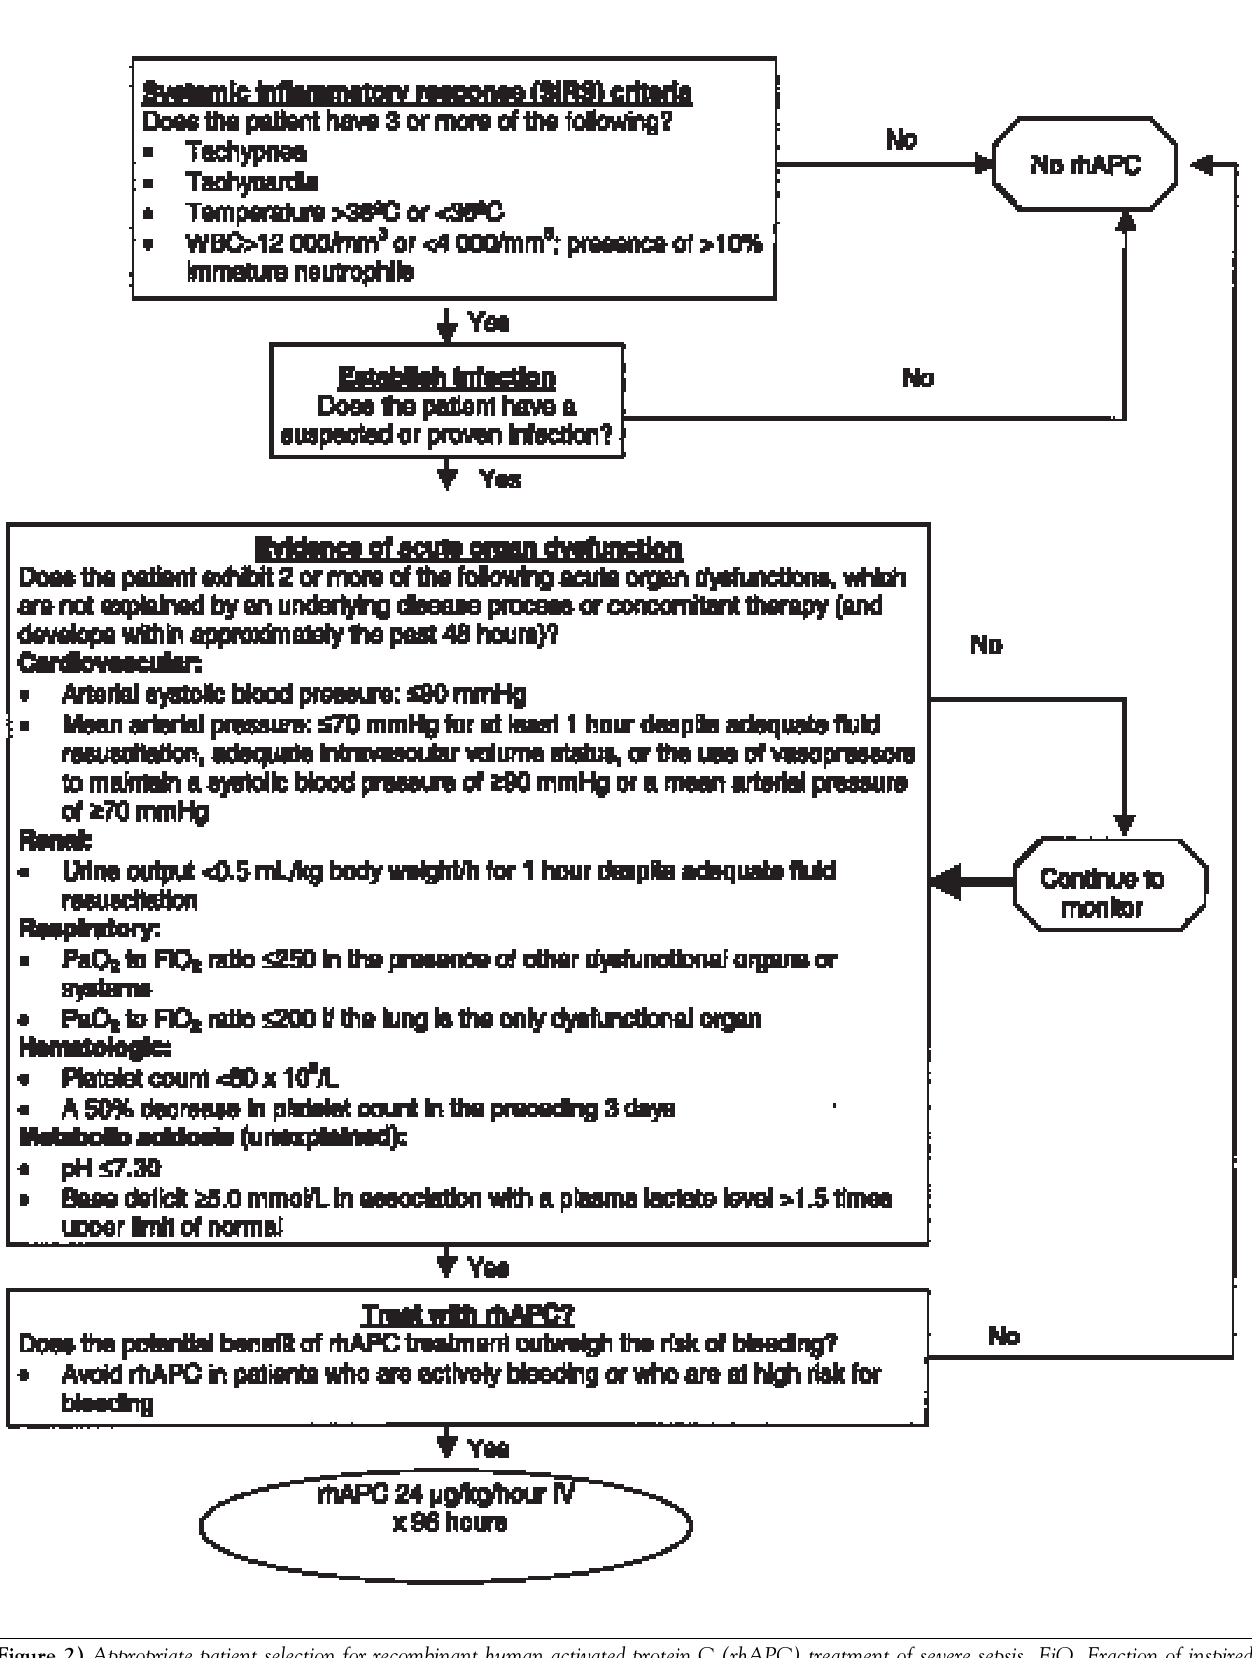
Figure 2) Appropriate patient selection for recombinant human activated protein C (rhAPC) treatment of severe sepsis. FiO oxygen; PaO Partial pressure of oxygen in arterial blood; SIRS Systemic inflammatory response syndrome; WBC White blood 2